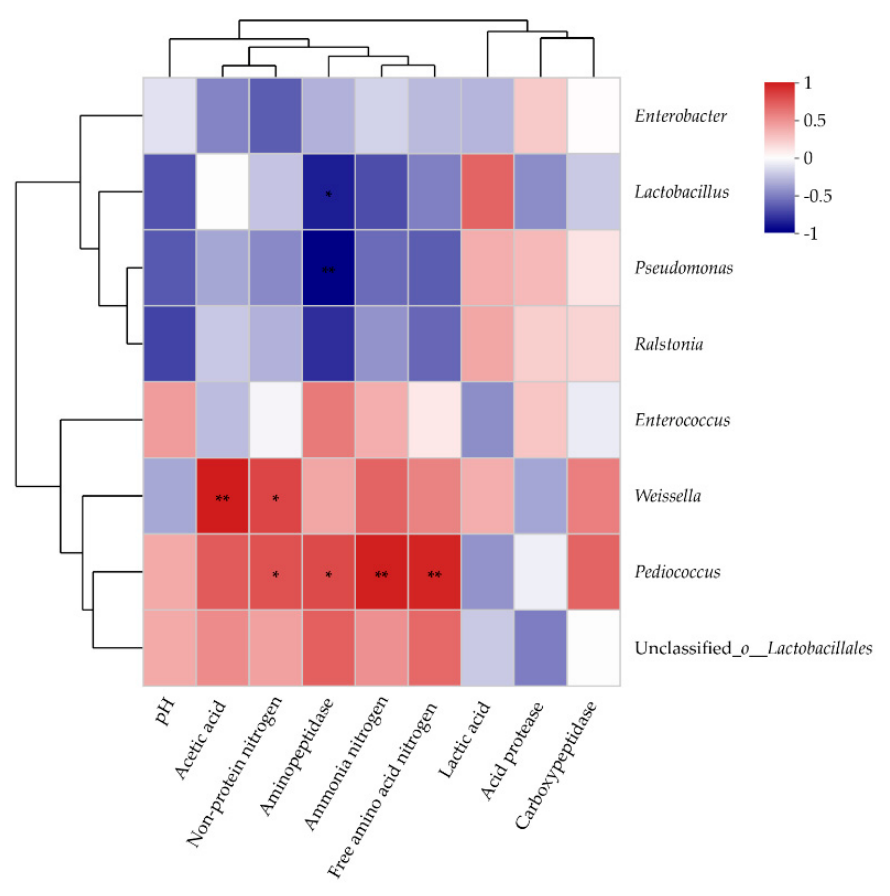
Figure 3. The correlation between microorganisms and fermentation parameters at the genus level using Spearman’s correlation analysis. Correlation R values and p -values were obtained through calculation. R values are shown in different colors in the figure. If p -values are less than 0.05, they are marked with as follows: * 0.01 < p ≤ 0.05, ** 0.001 < p ≤